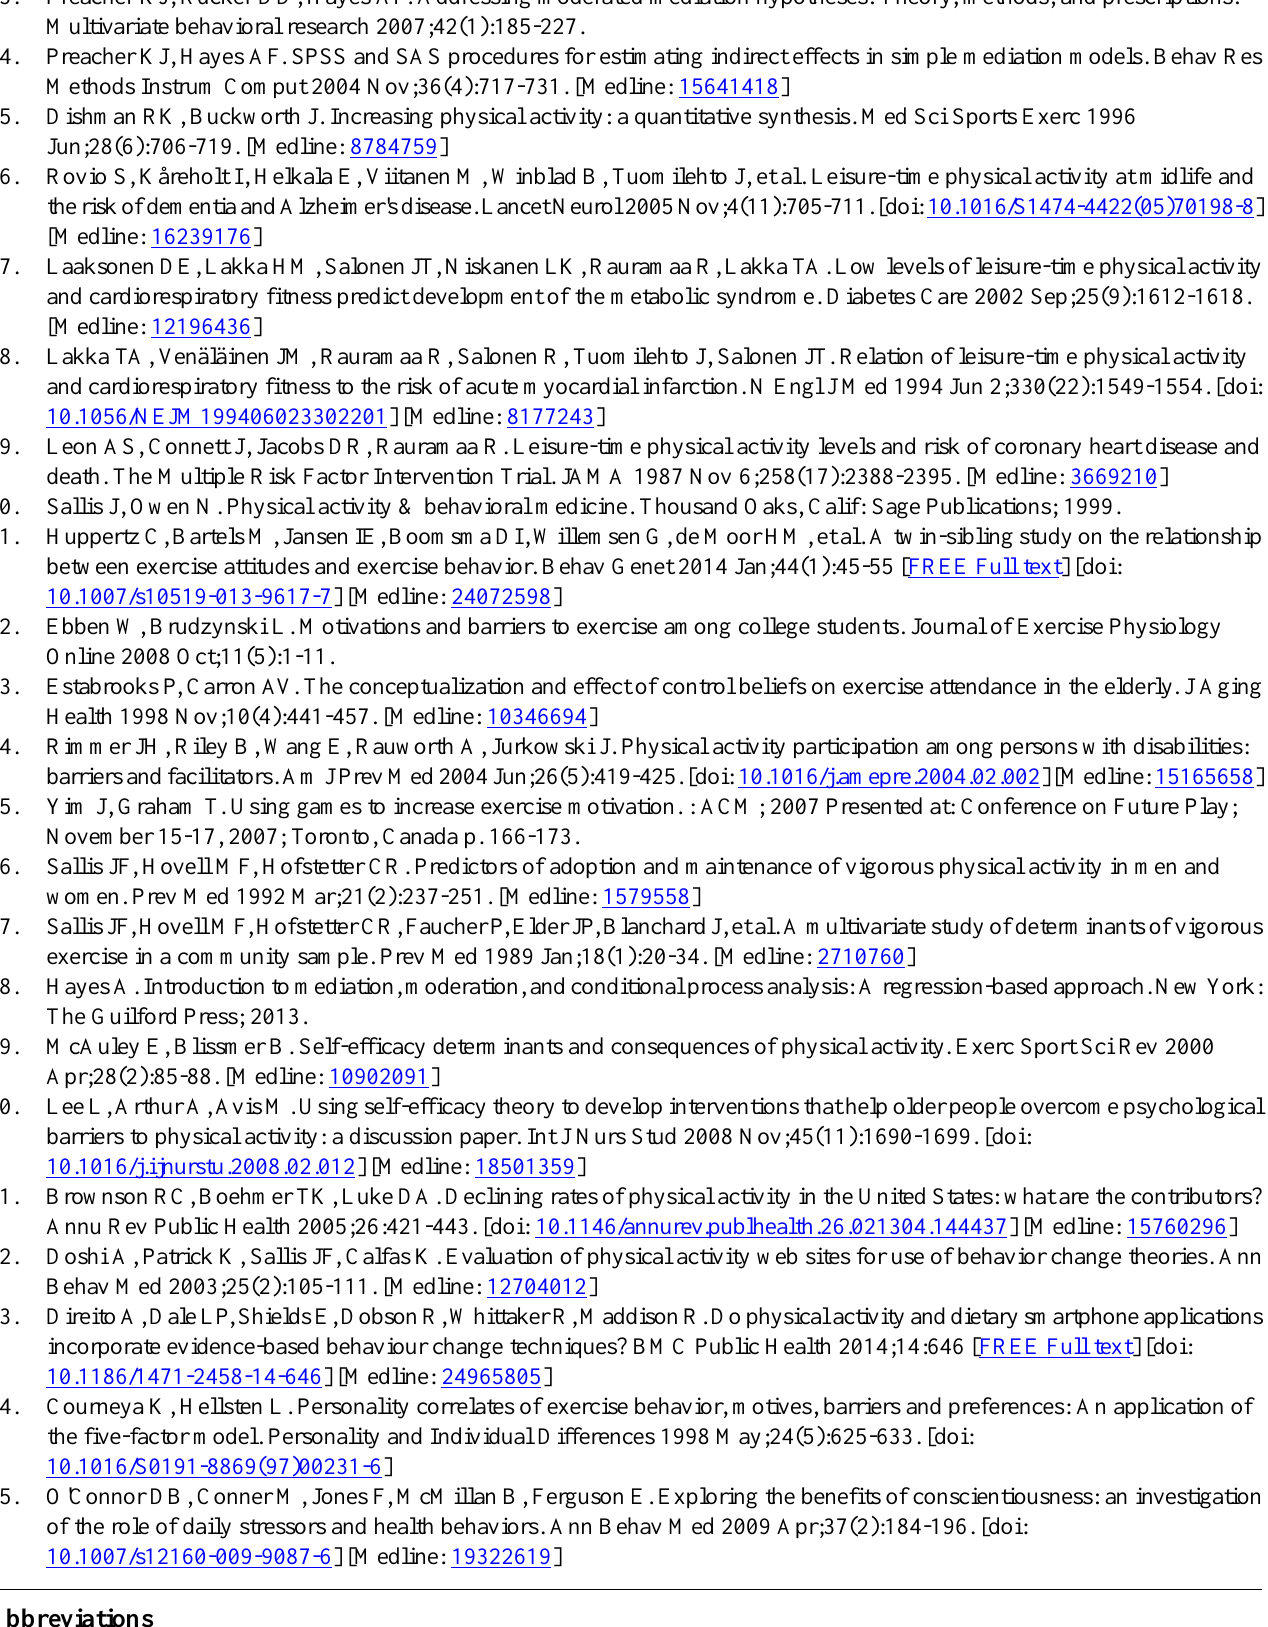
Abbreviations ANOVA: analysis of